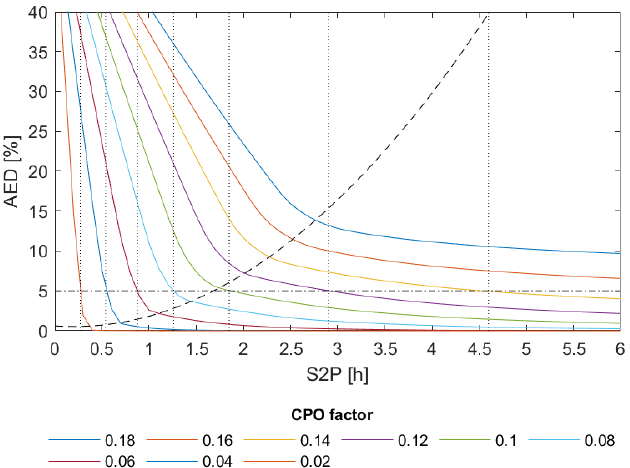
Figure 5. AED according to the S2P and CPO factors for the annual constant power setpoint (ACPS).